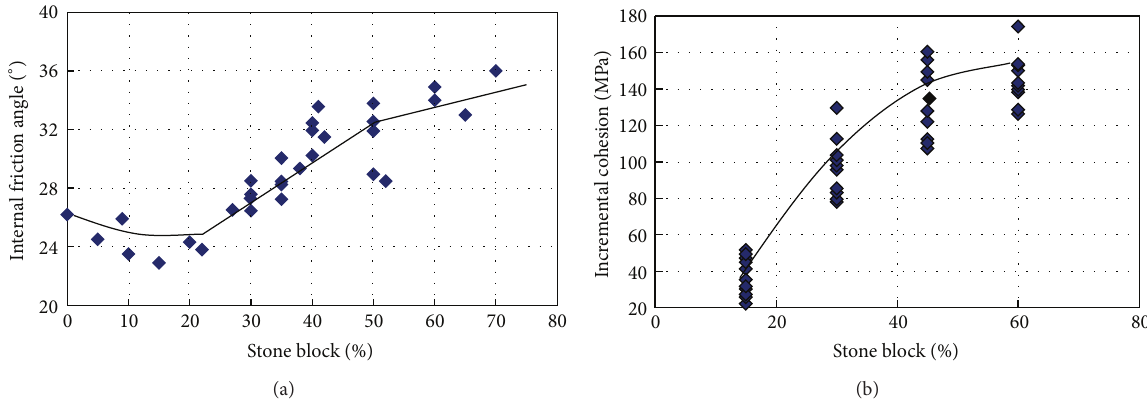
Figure 18: Changes of shear strength of outwash deposits with different contents and distributions of stone blocks; (a) shows changes of the internal friction of outwash deposit; (b) shows changes of the cohesion of outwash